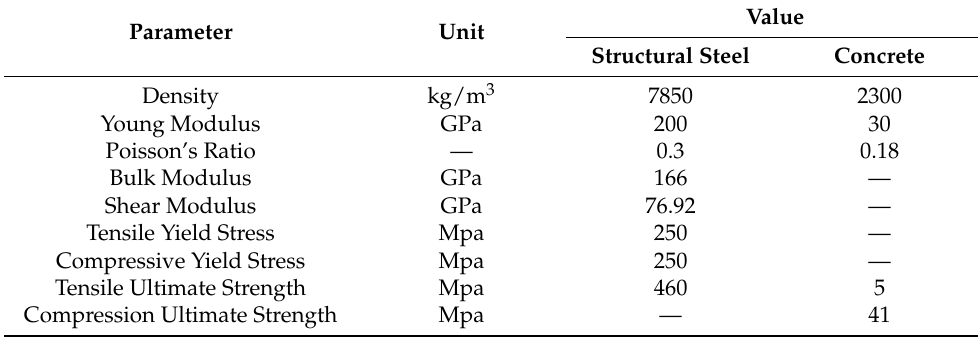
Table 1. Mechanical characteristics of the primary materials used in this case study. Parameter